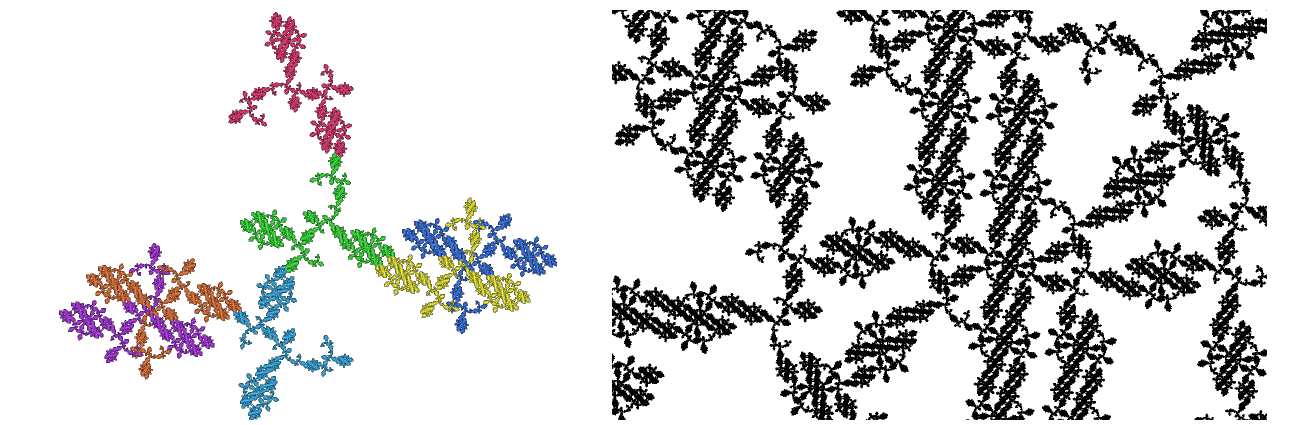
Figure 6. A pattern of dimension 1.69 generated from ( 3,4,5 ) together with 90 ◦ rotations. Such patterns are fairly easy to generate. This one has only 9 neighbor types.